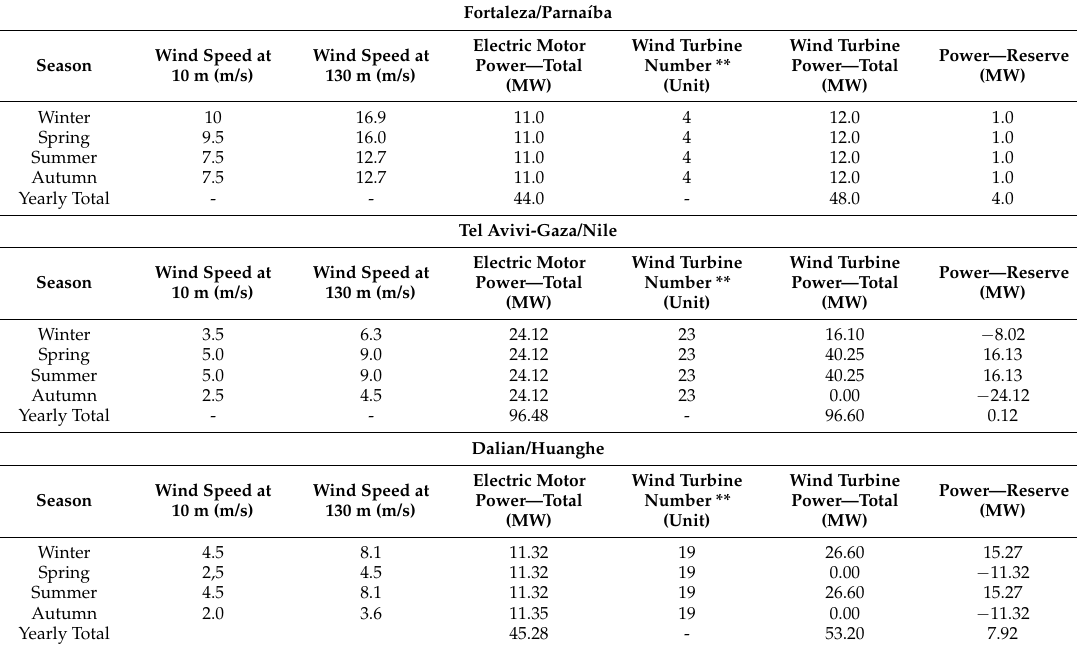
Table 13. Dimensioning of Wind Farms for pipelines. Scenario 1 (200